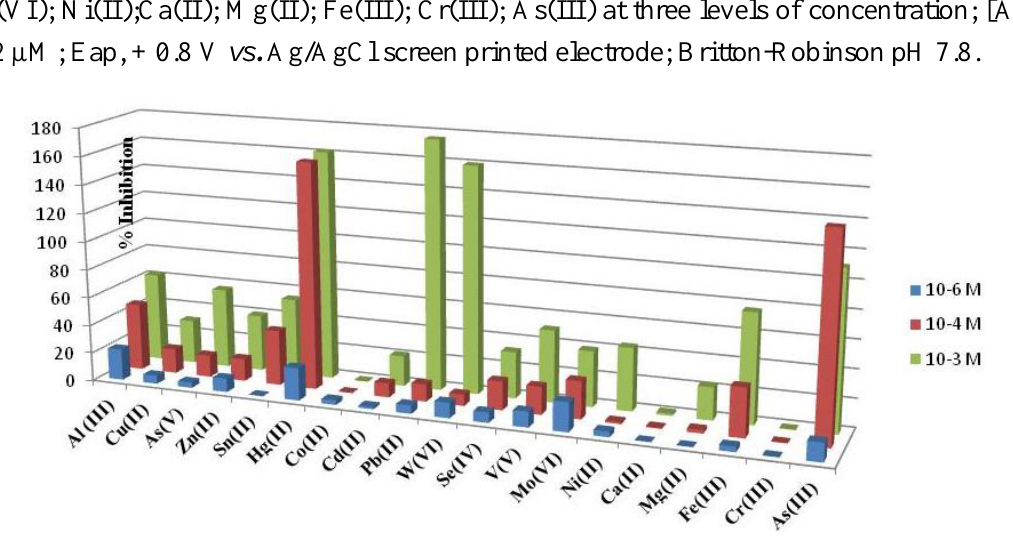
Figure 5. Inhibition percentage of inhibition current of ACh AuNPs/SPCE in presence of: Cu(II); As(V); As(III); Zn(II); Sn(II); Hg(II); Co(II); Cd(II); Pb(II); W(VI); Se(IV); V(V); Mo(VI); Ni(II);Ca(II); Mg(II); Fe(III); Cr(III); As(III) at 10 −6 M; [ATI] 0.12 µM; Eap, + 0.8 V vs. Ag/AgCl screen printed electrode; Britton-Robinson pH